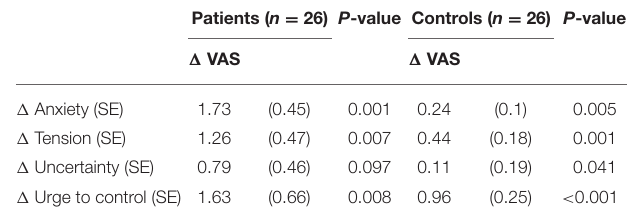
TABLE 3B | Provoked emotional